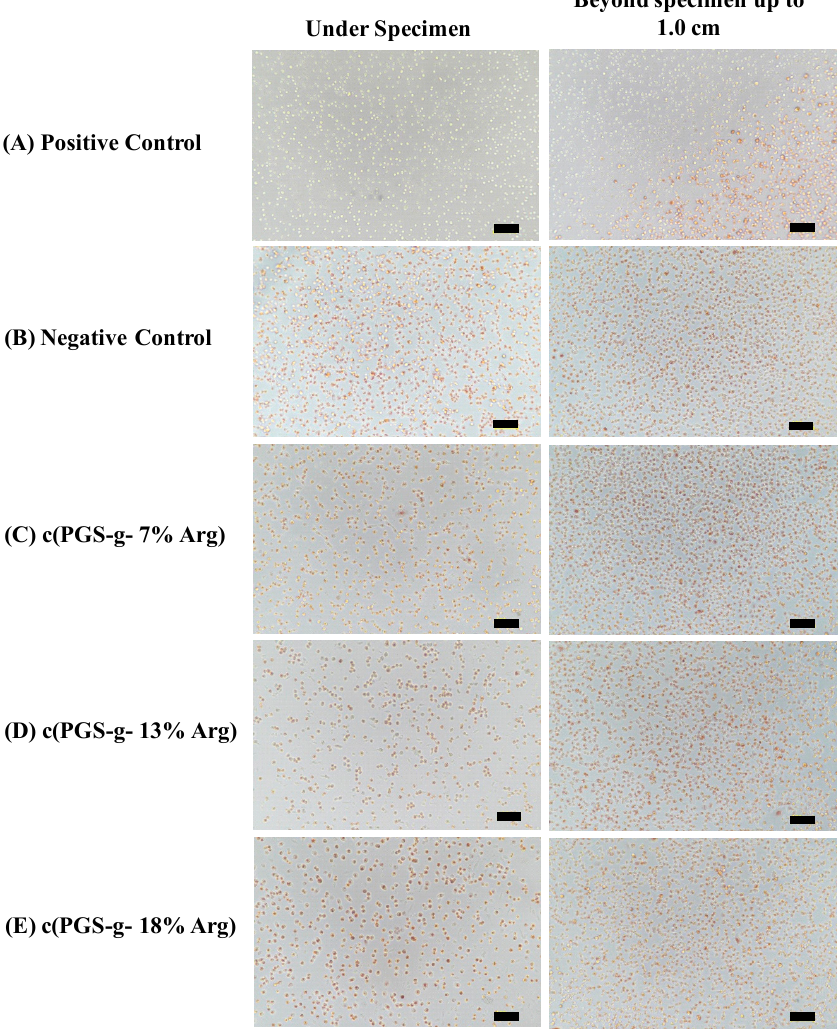
Figure 7. Optical observation of L929 cell lines via neutral red staining (scale bar 100 µ m). Table 4. Evaluation of cytocompatibility of c(PGS-g-Arg) films ( n = 3). Table 4. Evaluation of cytocompatibility of c(PGS-g-Arg) films ( n = 3). Tested Sample ( n =